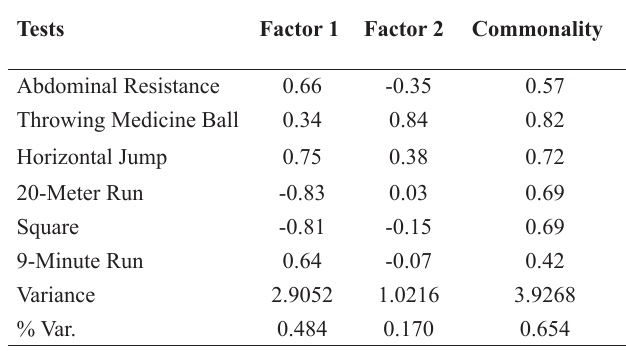
Table 3. Result of correspondence factors of each physical test stipu- lated by PROESP-BR of